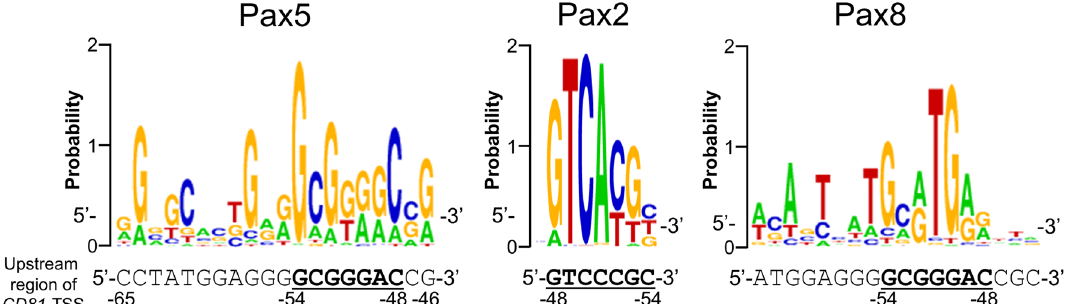
Figure 7. Pax5 consensus binding sequences and Pax5 core binding site in the promoter region of the CD81 gene. Pax5, Pax2, and Pax8 consensus binding sequences are shown as sequence logos, which were generated using ISMARA (Integrated System for Motif Activity Response Analysis) (https:// ismara. unibas. ch/ mara/). For each position, the percentage occurrence of each DNA base is indicated. The lower DNA sequence of the Pax5 logo is the Pax5 consensus binding site, (-65)CCT ATG GAGGG GCG GGA C CG(-46), within the promoter region of the CD81 gene. The Pax5 core binding sequence, (-54) GCG GGA C (-48), is shown in bold text and underlined. The lower DNA sequence of the Pax2 logo is the complementary sequence of (-54)GCG GGA C(-48). The (-54)GCG GGA C(-48) 7 bp sequence, which we identified as the Pax5 core binding site, matched 100% (7/7), 85.7% (6/7), and 71.4% (5/7) of the consensus binding sequence of Pax5, Pax2, and Pax8,